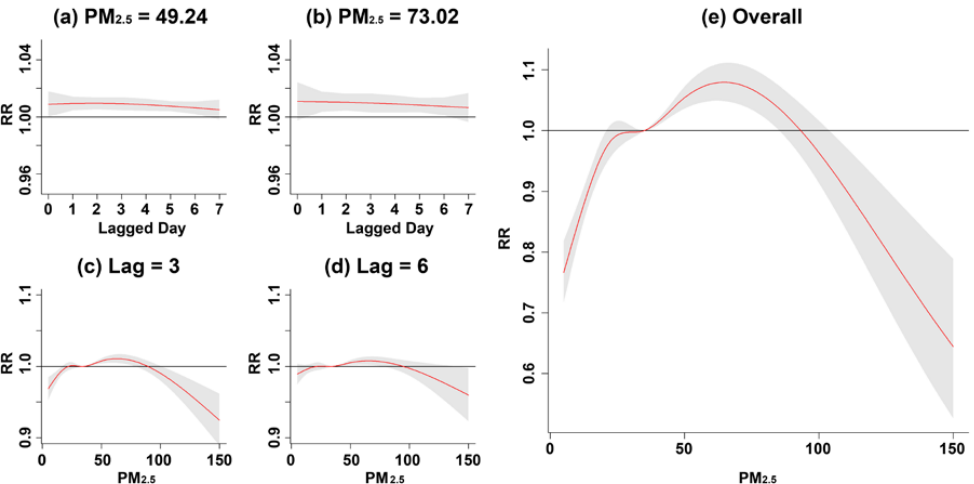
Figure 5. Overall relative risk and specific relative risk of children’s asthma with respect to selected PM 2.5 concentrations and lagged days.